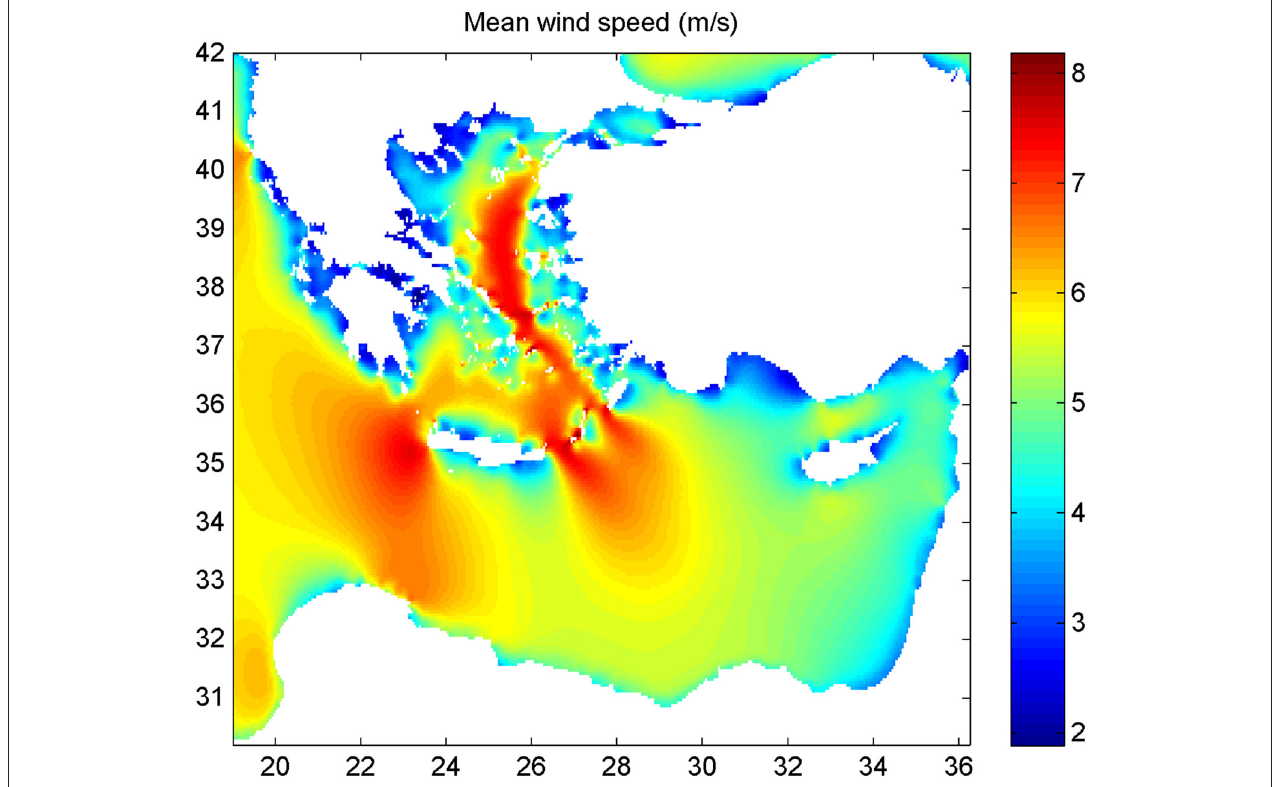
FIGURE 3 | Mean wind speed for the Eastern Mediterranean during